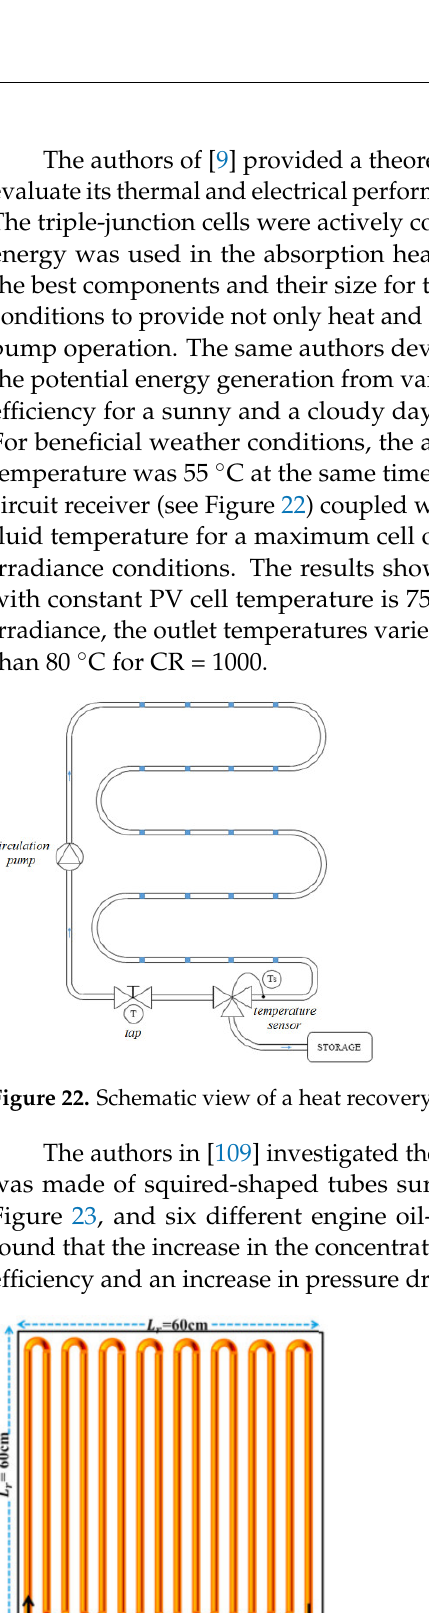
Figure 23. Riser tubes in the squired-shaped receiver [109]. Reprinted with permission from Ref. [109]. 2022, Elsevier.